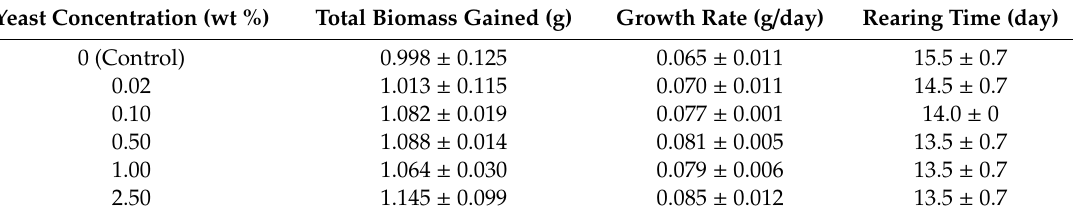
Table 1. Growth performances of BSFL fed with CEW having been inoculated with di ff erent yeast concentrations. Yeast Concentration (wt %) Total Biomass Gained (g) Growth Rate (g / day) Rearing Time (day) 0 (Control) 0.998 ±